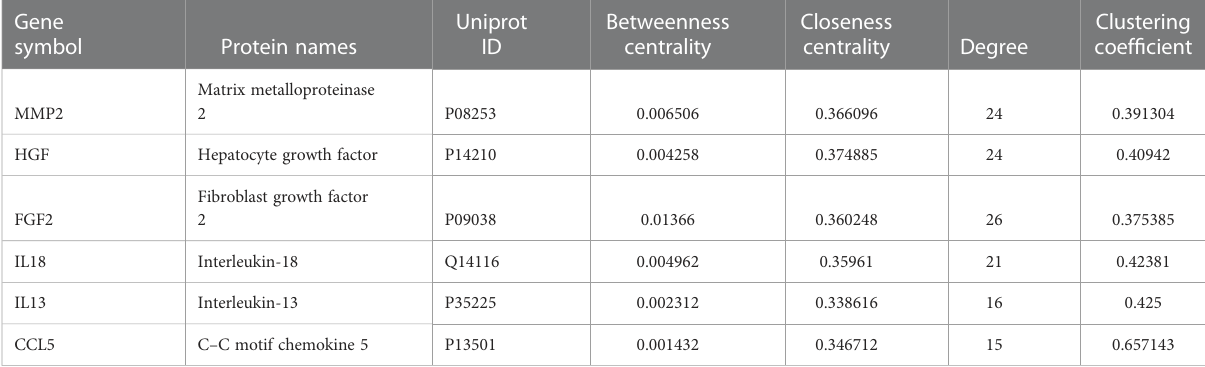
TABLE 1 Central risk genes for diabetic kidney disease with in fl ammatory bowel disease. Gene symbol Protein